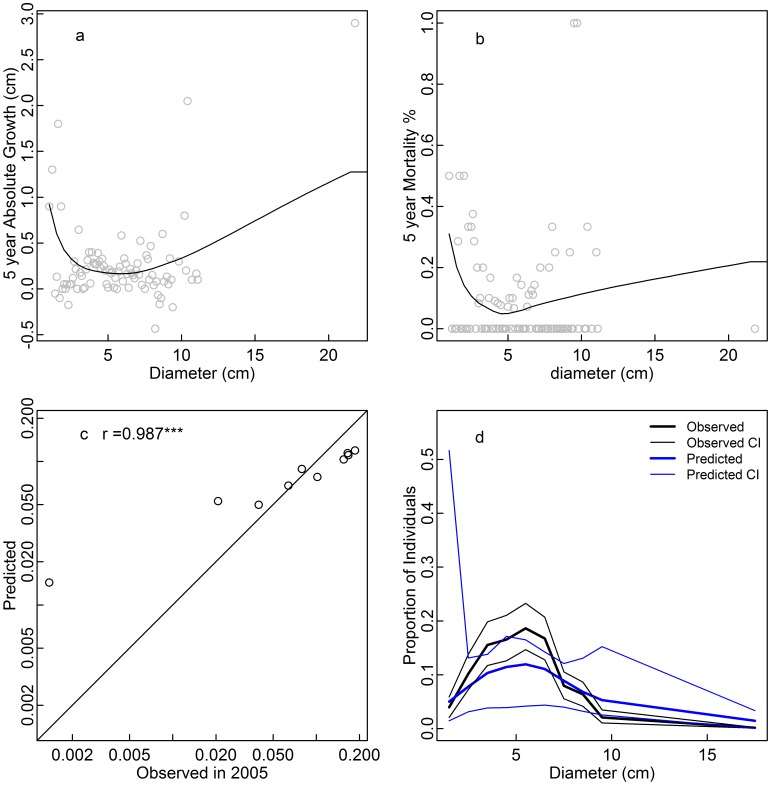
Five year absolute diameter growth (a), five year mortality rate (b), and observed 2005 vs. predicted equilibrium proportions of individuals in each size class (c,d) for Eurya macartneyi.The prediction was derived from growth and mortality functions under the assumption that the population is at demographic equilibrium. Confidence intervals were obtained from bootstrapping over 20×20 m subplots (d).